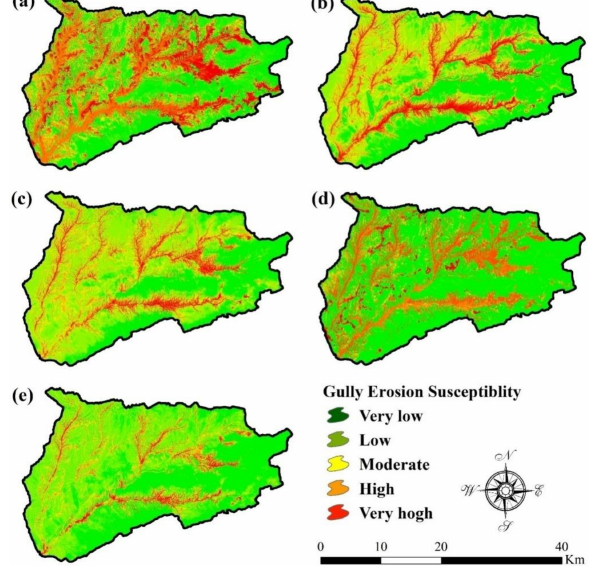
Figure 5. Gully erosion susceptibility mapping using the ANN model: ( a ) 50 / 50, ( b ) 60 / 40, ( c ) 70 / 30, ( d ) 80 / 20, and ( e ) 90 /